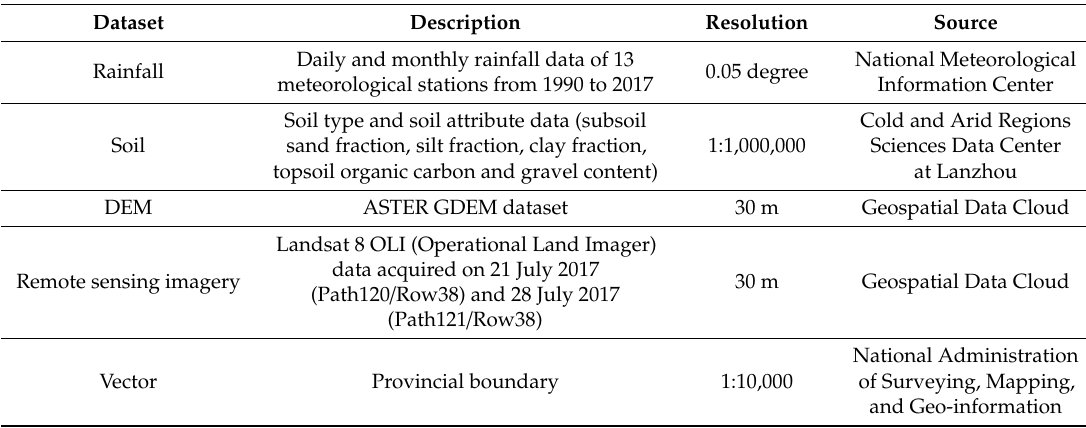
Table 1. Data used in this study.